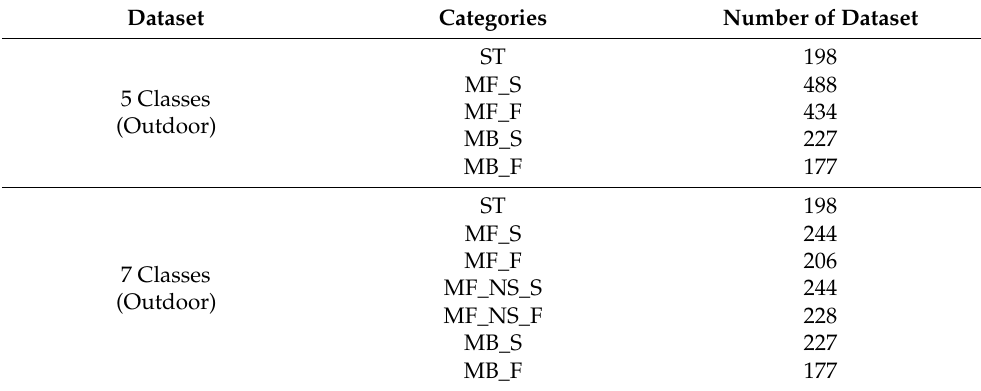
Table 4. Datasets from the Outdoor Experiment.